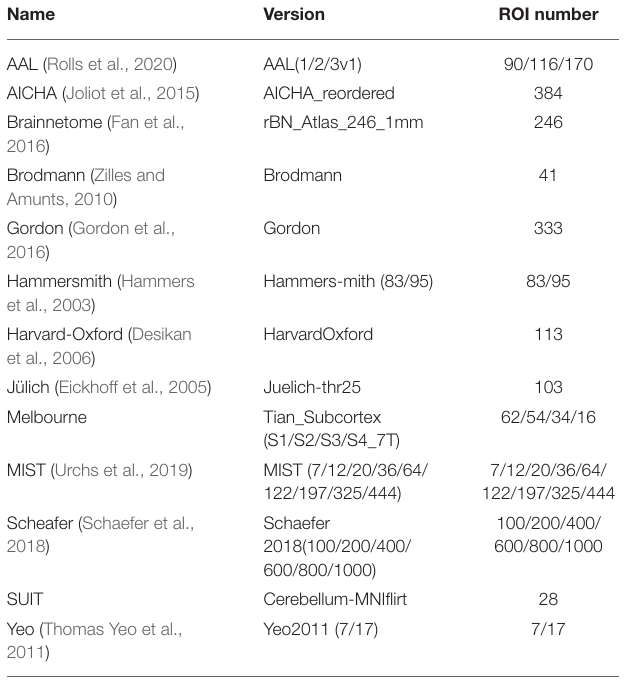
“Version” represents the name of each version, where the different versions are indicated in “()” and “ROI Number” represents the number of ROIs for the different